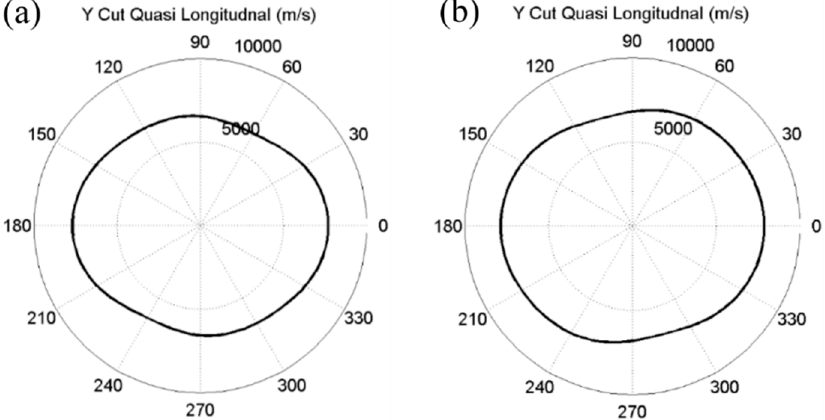
Figure 10. The directional group wave velocity plot in LiNbO 3 for longitudinal wave velocity ( a ) without piezo stiffening ( b ) with piezo stiffening mode.